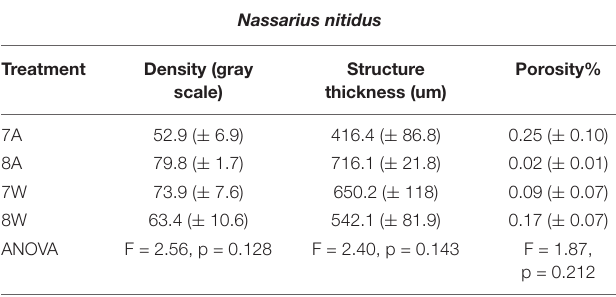
TABLE 1 | Mean density (gray scale values) of the total shell, structure thickness (um) and porosity% ( ± SE) for Nassarius nitidus in the four experimental treatments A (7A), B (8A), C (7W), and D (8W) as coded in the text (8A: 20 ◦ C and pH = 8; 7A: 20 ◦ C and pH = 7.7; 8W: 23 ◦ C and pH = 8; 7W: 23 ◦ C and pH = 7.7).